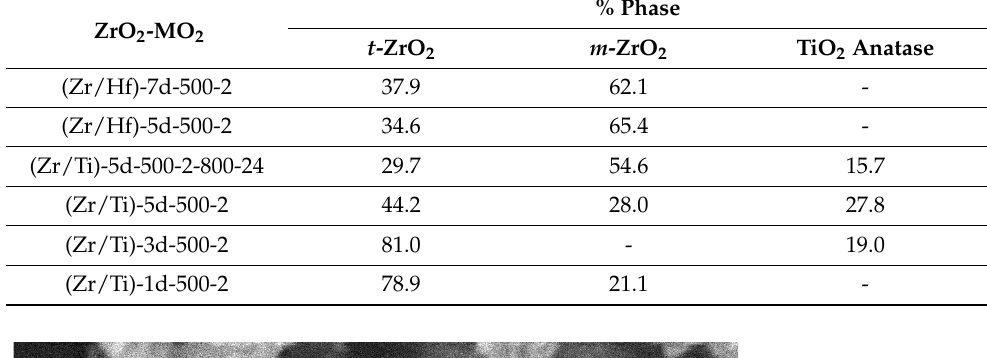
Figure 4. SEM image of ZrO 2 -TiO 2 composite for (Zr/Ti)-5d-500-2.